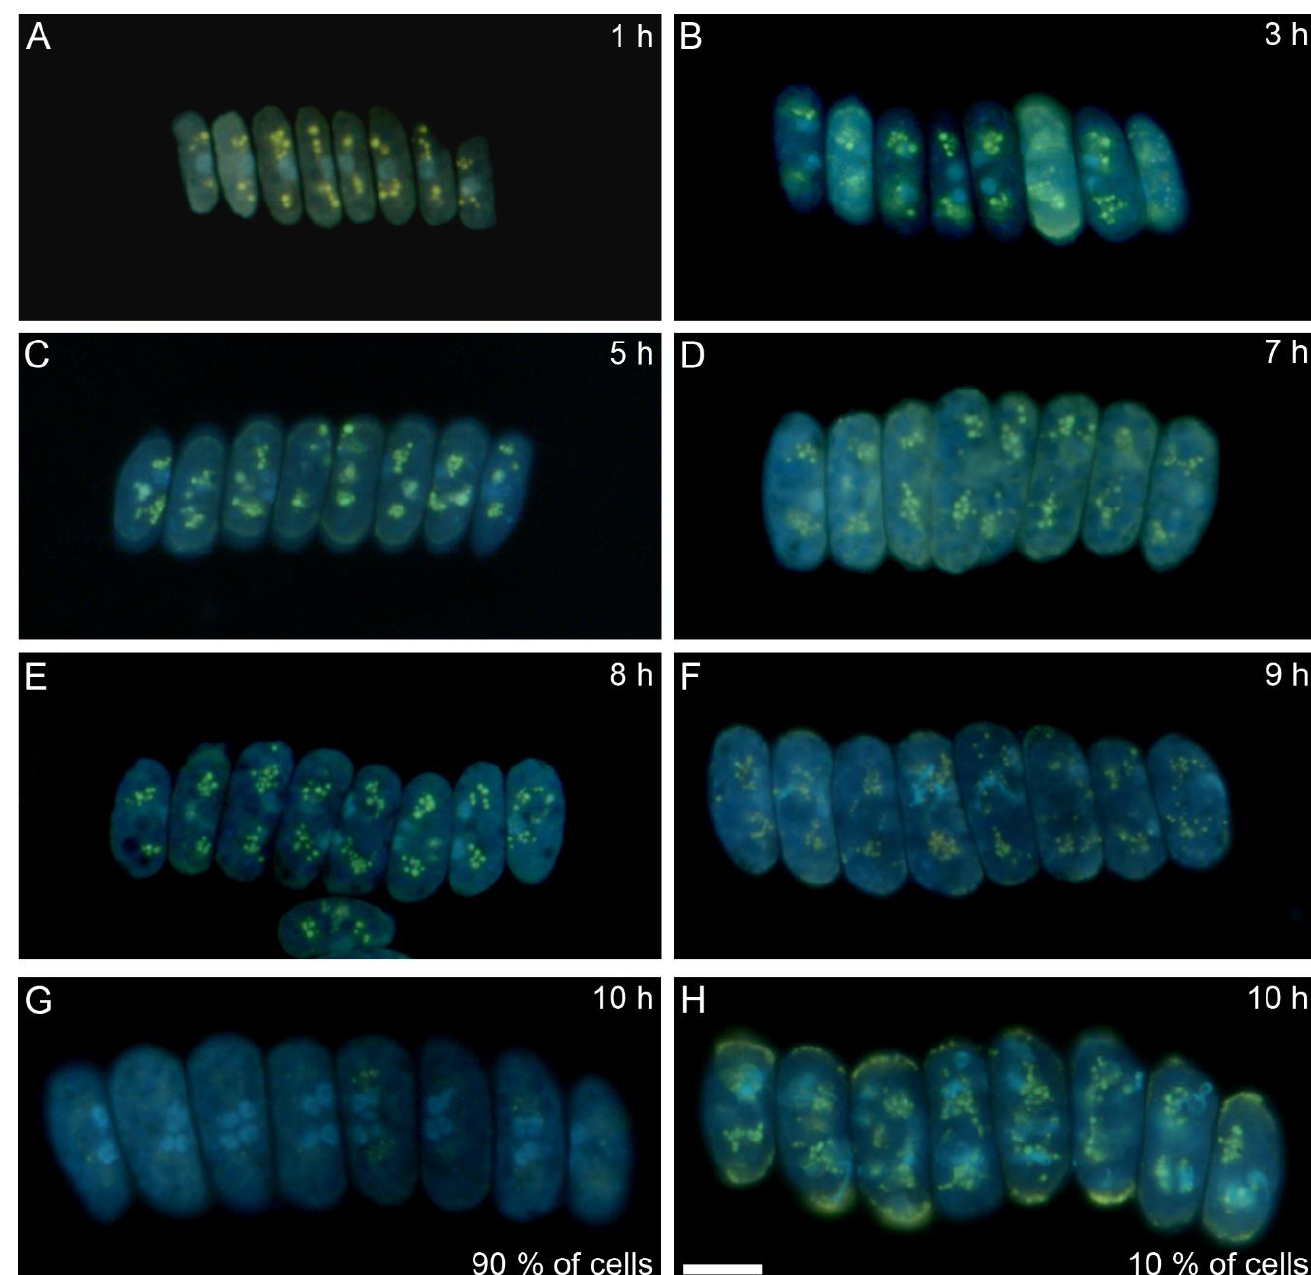
Figure 3. Fluorescence micrographs of coenobia stained by a high concentration of DAPI at different time points during the cell cycle. ( A ) 1st h, ( B ) 3rd h, ( C ) 5th h, ( D ) 7th h, ( E ) 8th h, ( F ) 9th h, ( G ) and ( H ) 10th h. G corresponds to situation in 90% of the cells in the synchronized population while H corresponds to situation in 10% of the cells in the synchronized population. Polyphosphates are visible as yellow spots; the bluish spots are nuclei. Bar is 10 µm.